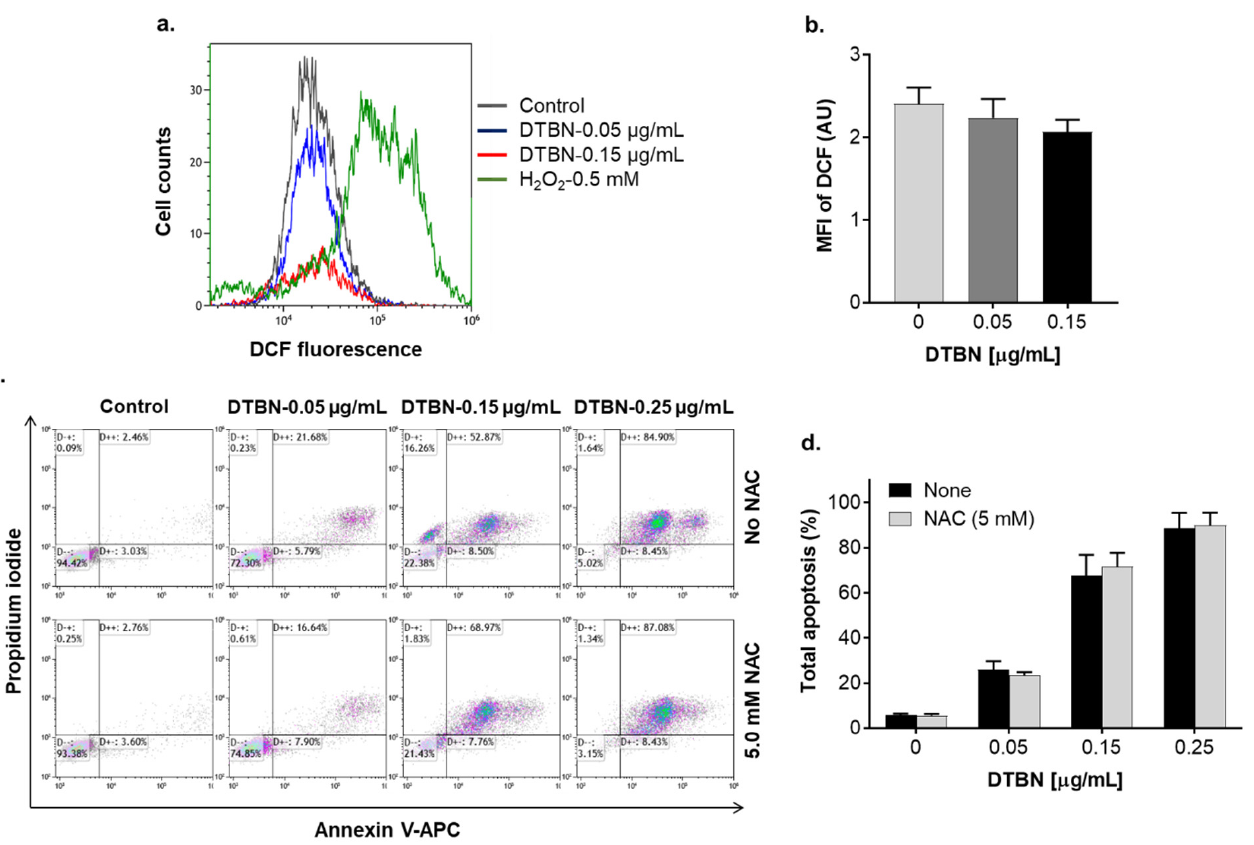
Figure 10. 6,6 ′ -dihydroxythiobinupharidine (DTBN)-induced apoptosis is not mediated by the cytosolic ROS. HL60 cells were pre-incubated with or without 5 µ M NAC for 1 h followed by the addition of the indicated concentrations of DTBN for another 24 h. The extent of apoptosis and cytosolic ROS levels were measured using the annexin-V/PI assay and the cytosolic ROS indicator DCFH-DA, respectively. ( a ) Typical flow cytometric data from a representative annexin-V/PI assay. ( b ) Averaged percentages of apoptotic (early + late) cells. ( c ) Typical examples of cytosolic ROS measurement from a representative experiment. H 2 O 2 (0.5 mM) was used as the positive control. ( d ) Averaged ROS levels expressed as DCF geometric mean fluorescence intensity (MFI) units. The data are means ± SD of 3 independent experiments performed in duplicate.